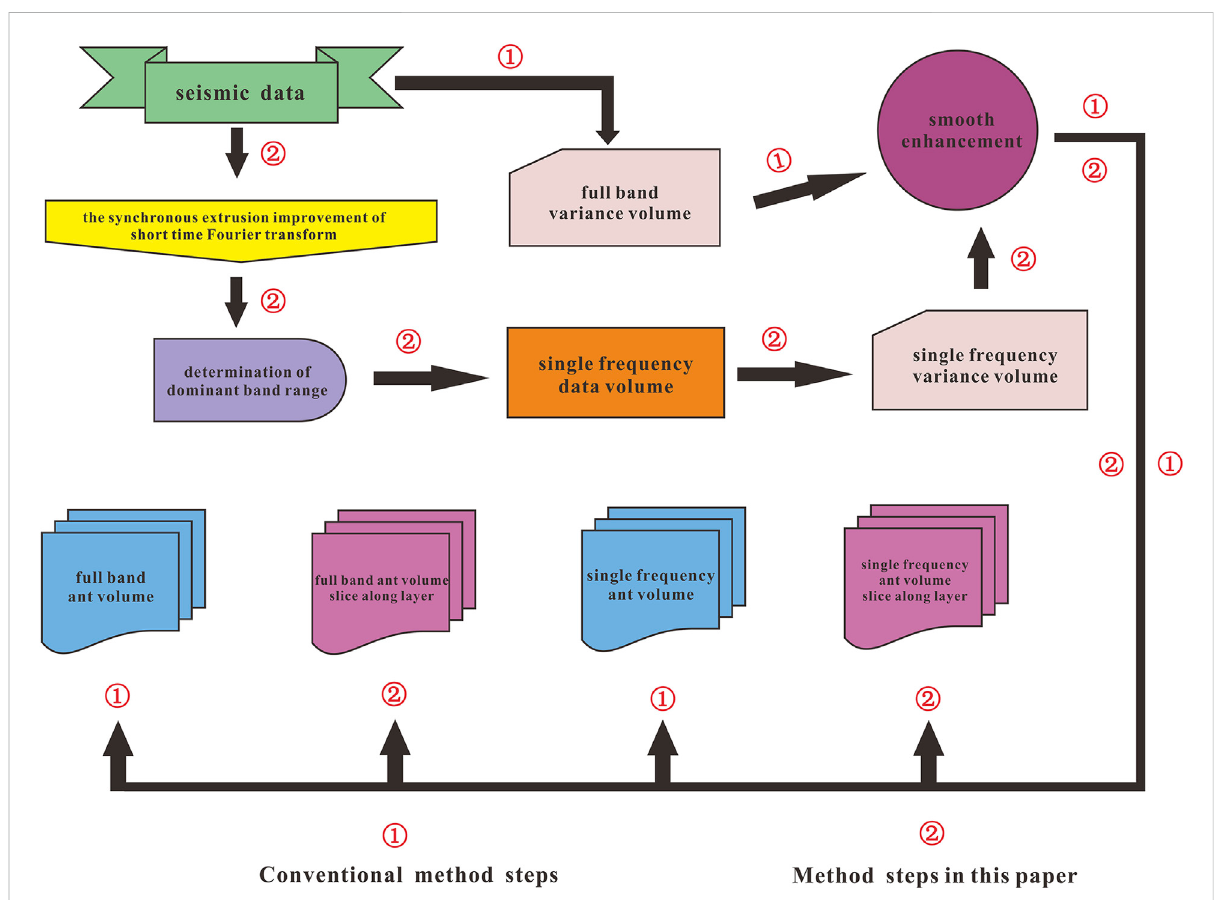
FIGURE 3 Improved ant tracing process framework of short-time Fourier transform based on synchronous extrusion. ① Conventional method steps. ② Method steps in this